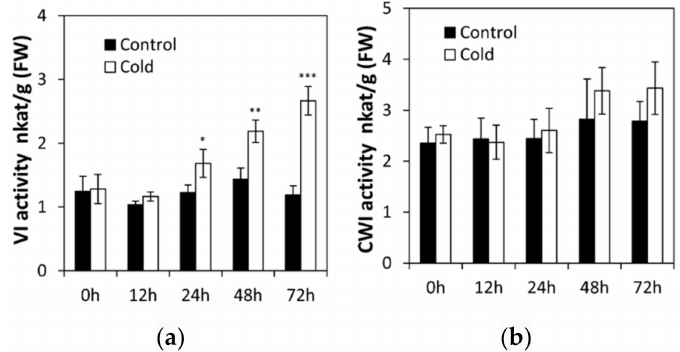
Figure 1. Effect of low temperature treatment of cucumber seedlings on the root vacuolar invertase ( a ) and cell wall invertase ( b ) activities. Cell wall invertase, CWI; vacuolar invertase, VI. Results are means of >3 biological replicates ( ± SE) each with three technical replicates. Asterisks indicate statistically significant differences (*, p value < 0.05; **, p value < 0.01; ***, p value <